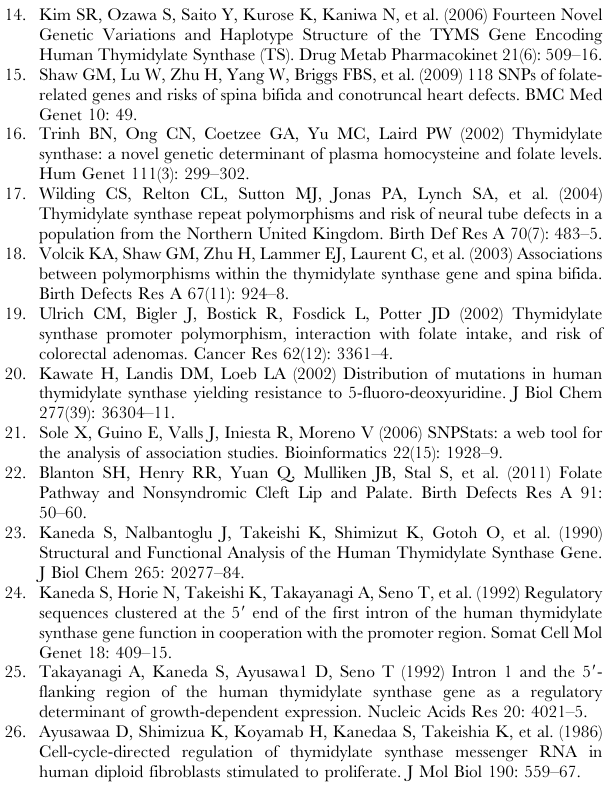
Table S1 DNA sequence of all used primer pairs. (DOC)